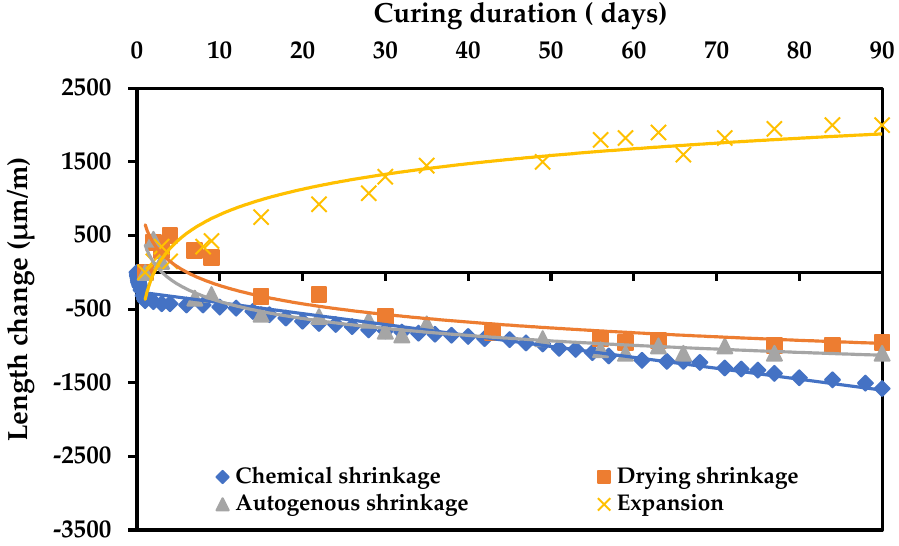
Figure 10. Length change of pastes with 0% LF.